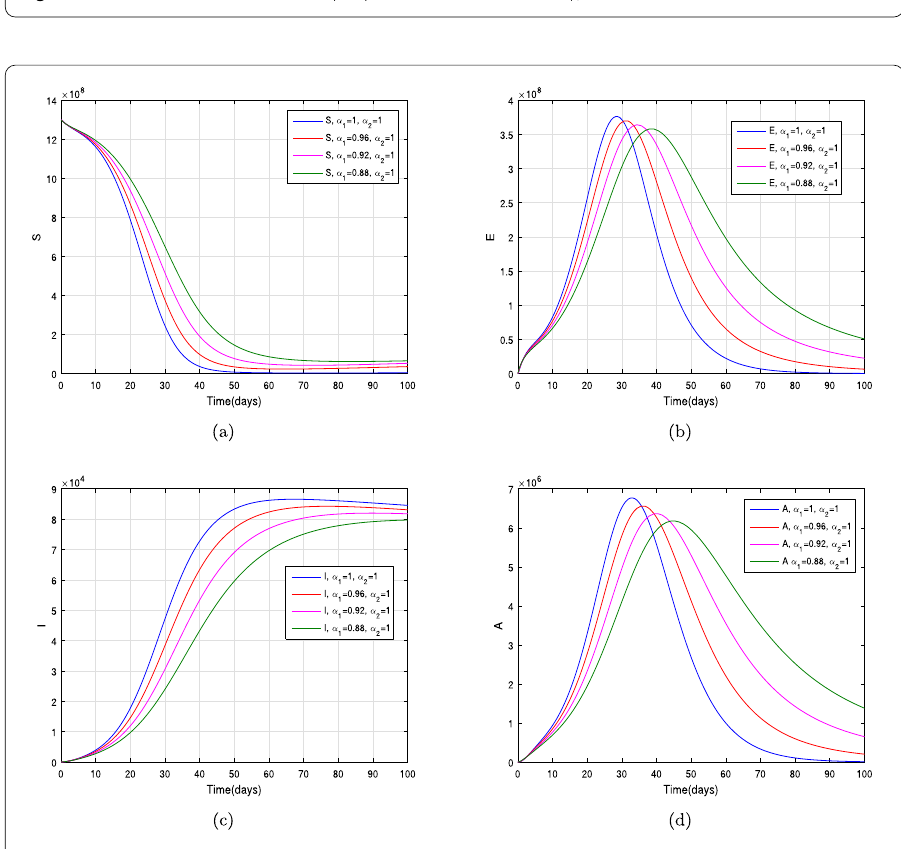
Figure 9 The dynamics of the model variables for α 1 = 1,0.96,0.92,0.88 and α 2 = 1, subfigures (a)–(d) respectively represent the susceptible, exposed, infected, and asymptomatic